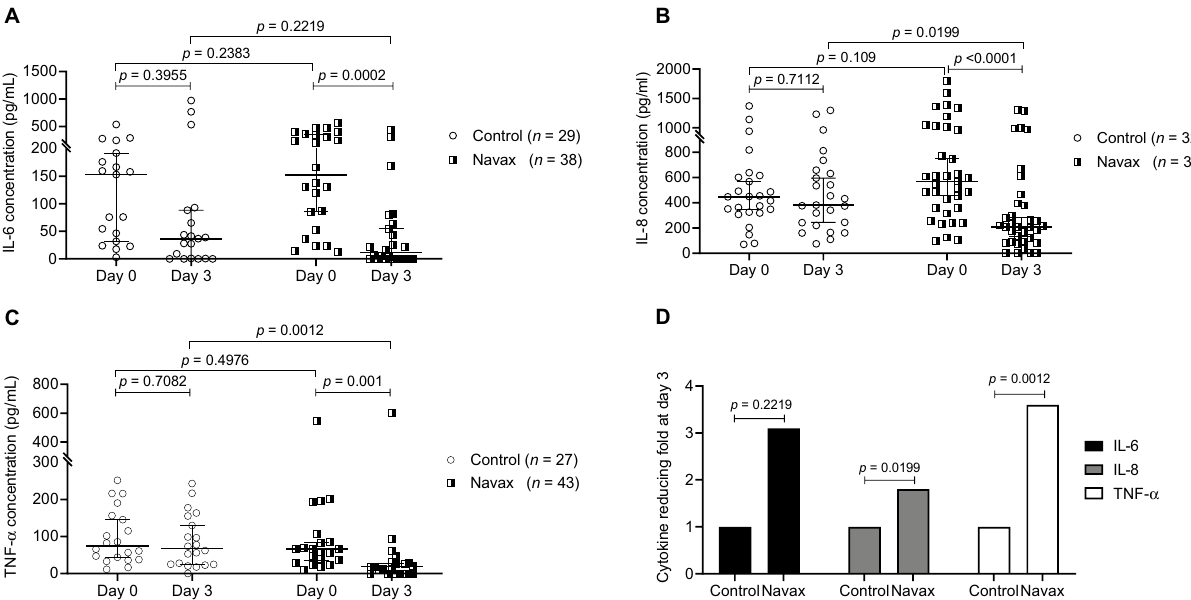
Figure 5. Pro-inflammatory cytokines levels (pg/mL) in nasopharyngeal samples of Control and Navax groups at day 3 compared to day 0. The Wilcoxon test was used to calculate the median differences in (i) IL-6 ( A ), IL-8 ( B ), TNF-α ( C ) levels at day 0 and day 3 in each group. The Mann–Whitney test was used to compared cytokine concentrations ( A – C ) and cytokine reducing folds ( D ) between the two groups. Only samples with measurable cytokine concentrations at day 0 were included in the statistical analysis. 95% CI for median in each group and the median difference between the two groups were shown in ( A – C ). The significance level of all analyzes was set at the p <